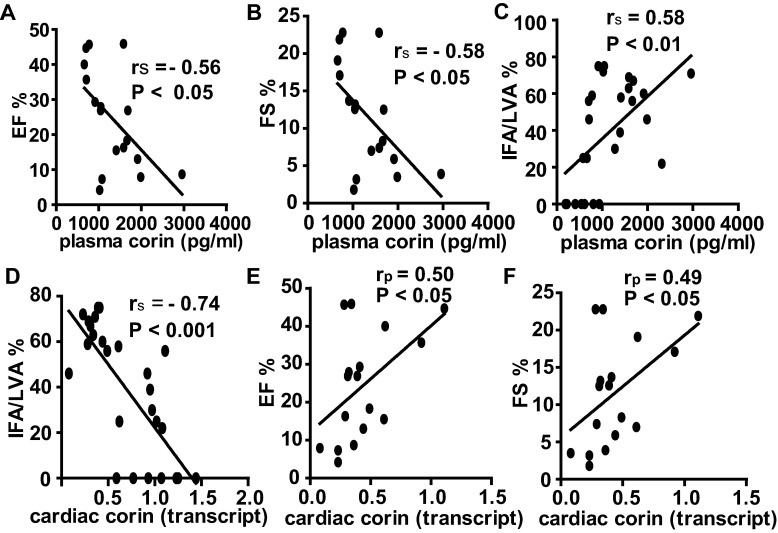
Correlation between corin level, cardiac function and myocardial infarct size.Plasma corin levels were negatively correlated with EF (A) and FS (B). (C) Plasma corin levels were positively correlated with infarct size while (D) Corin cardiac transcript levels were negatively correlated with infarct size. Cardiac corin transcript levels were positively correlated with EF (E) and FS (F). All mice from 3 h, 24 h and 72 h post-MI are presented. P-values provided in each individual panel.